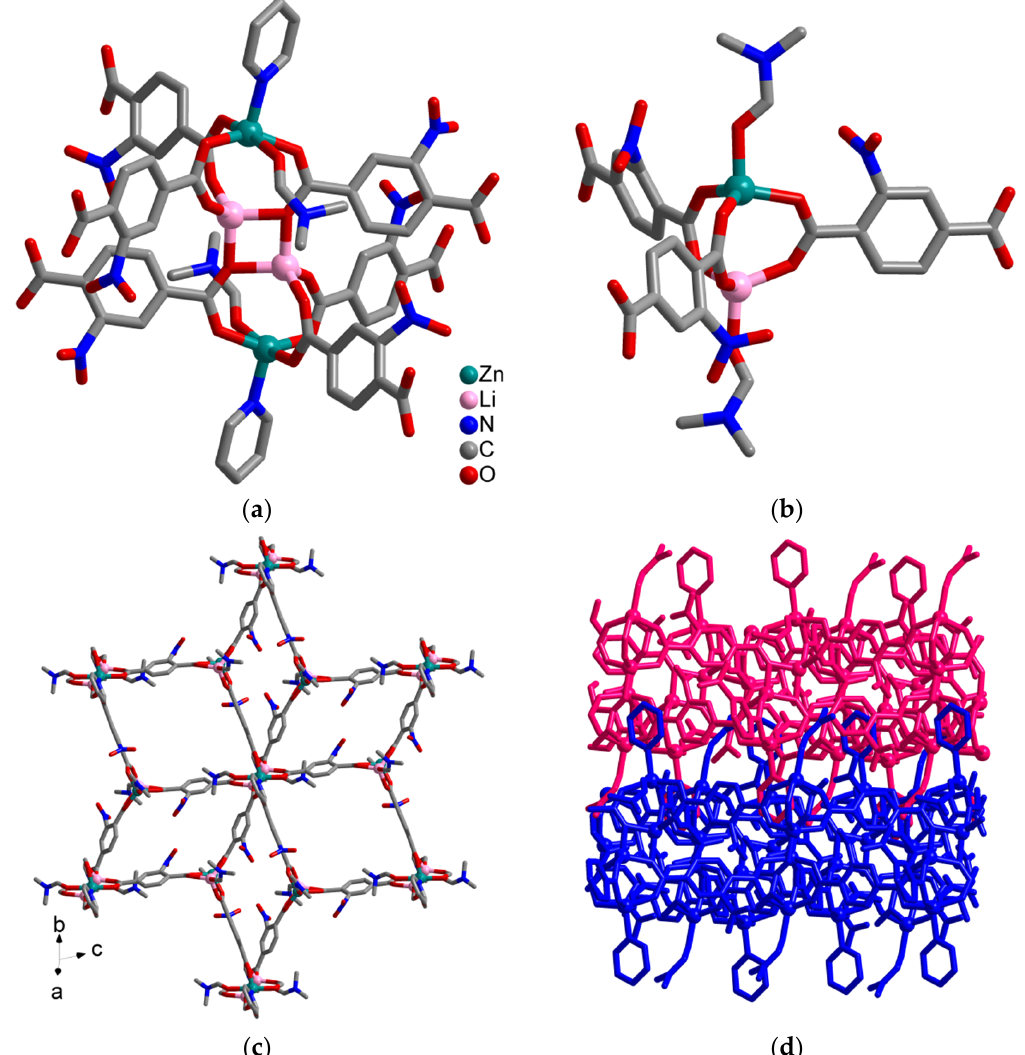
Figure 5. ( a ) Tetranuclear SBU in compound 4 ; ( b ) Dinuclear SBU in compound 4 ; ( c ) Connectivity of tetranuclear and dinuclear SBUs in 4 ; ( d ) AB packing of layers in 4 , layers shown in different colors. Compounds 1, 2 and 3 were obtained as individual products in good yields (>50%).